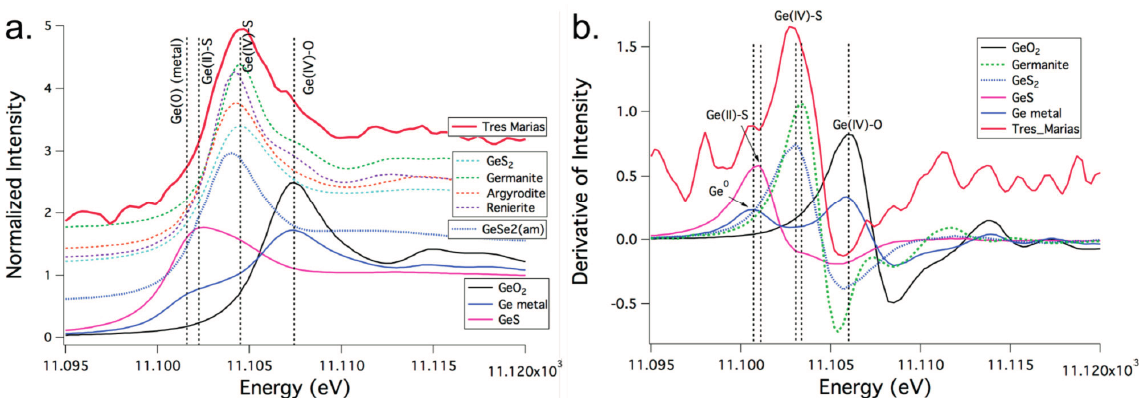
Figure 6. Ge K-edge XANES data for the Tres Marias sample compared to standards (( a ) normalized; ( b ) first